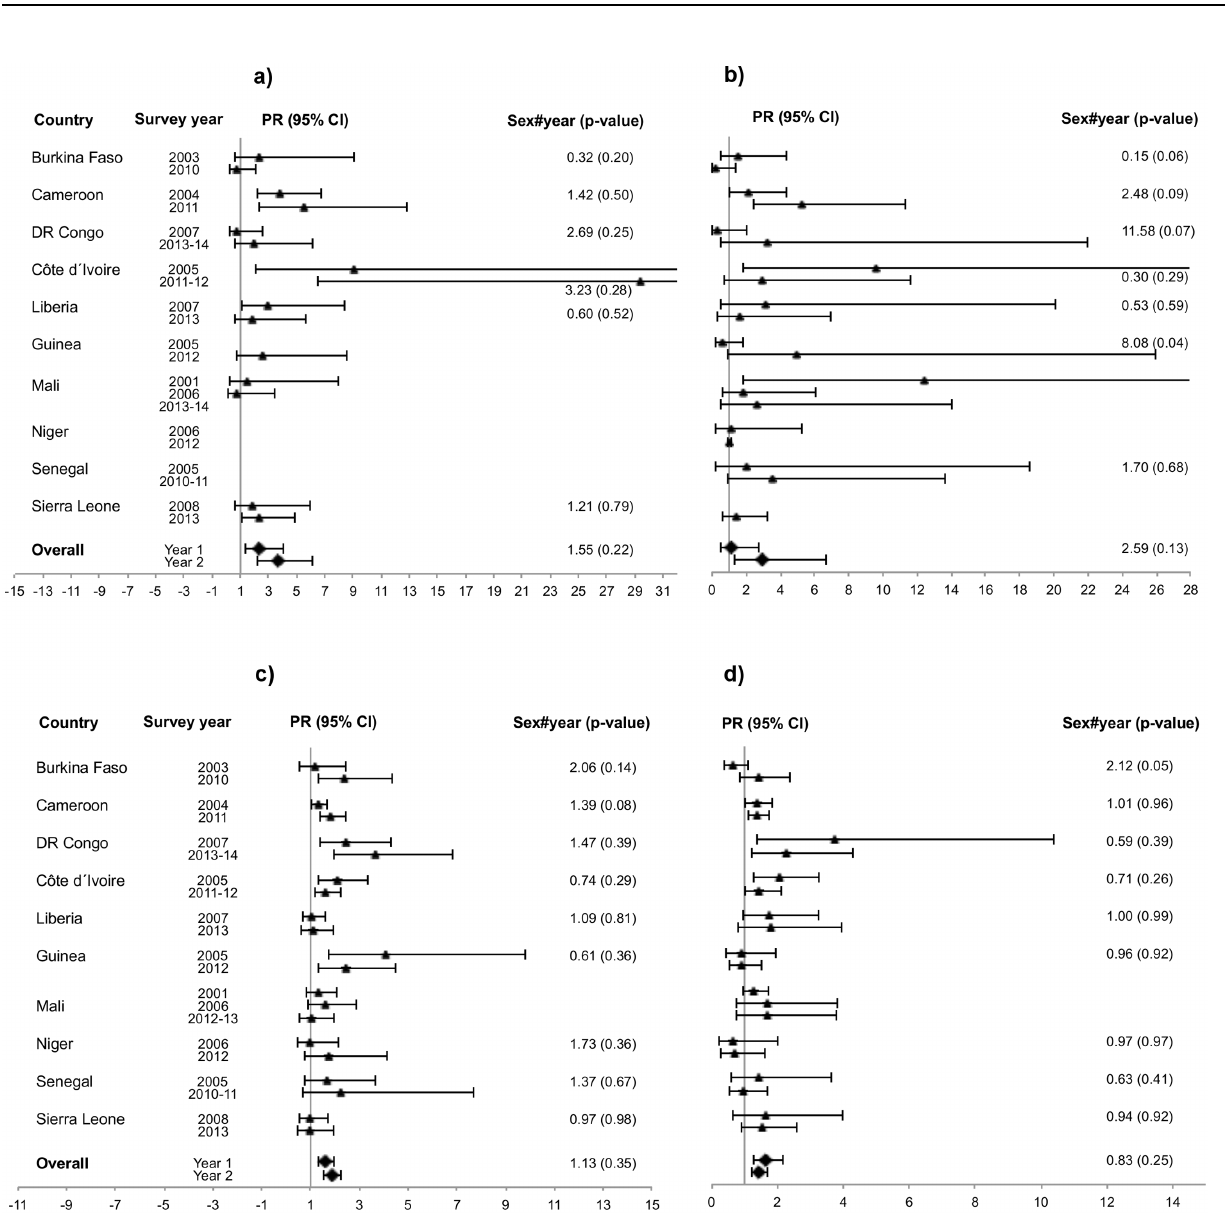
Fig 1. Western/Central Africa, age-adjusted female: male HIV prevalence ratios. (a) Urban, 15 – 24 years. (b) Rural, 15 – 24 years. (c) Urban, 25 – 49 years (d) Rural, 25 – 49 years.